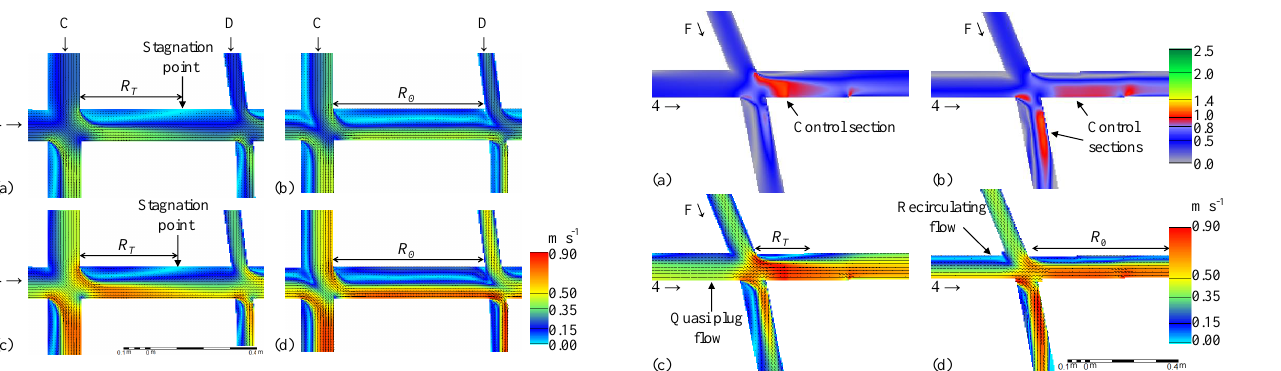
Figure 11. Froude numbers (a, b) and velocity fields (c, d) com- puted with (a, c) and without (b, d) the turbulence model for test Q100-W050 (c, d) . Grid size: